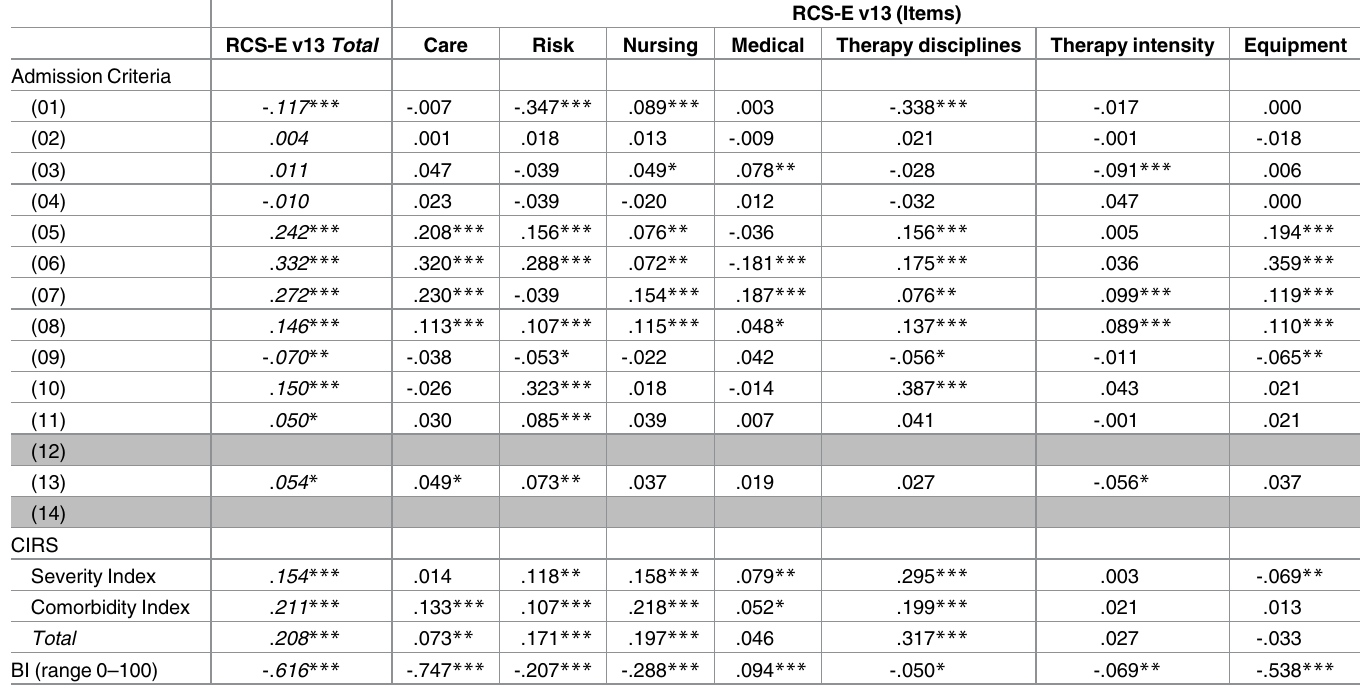
Table 5. Spearman’scorrelation matrix of the RCS-E v13 scores to Admission Criteria, CIRS and Barthel